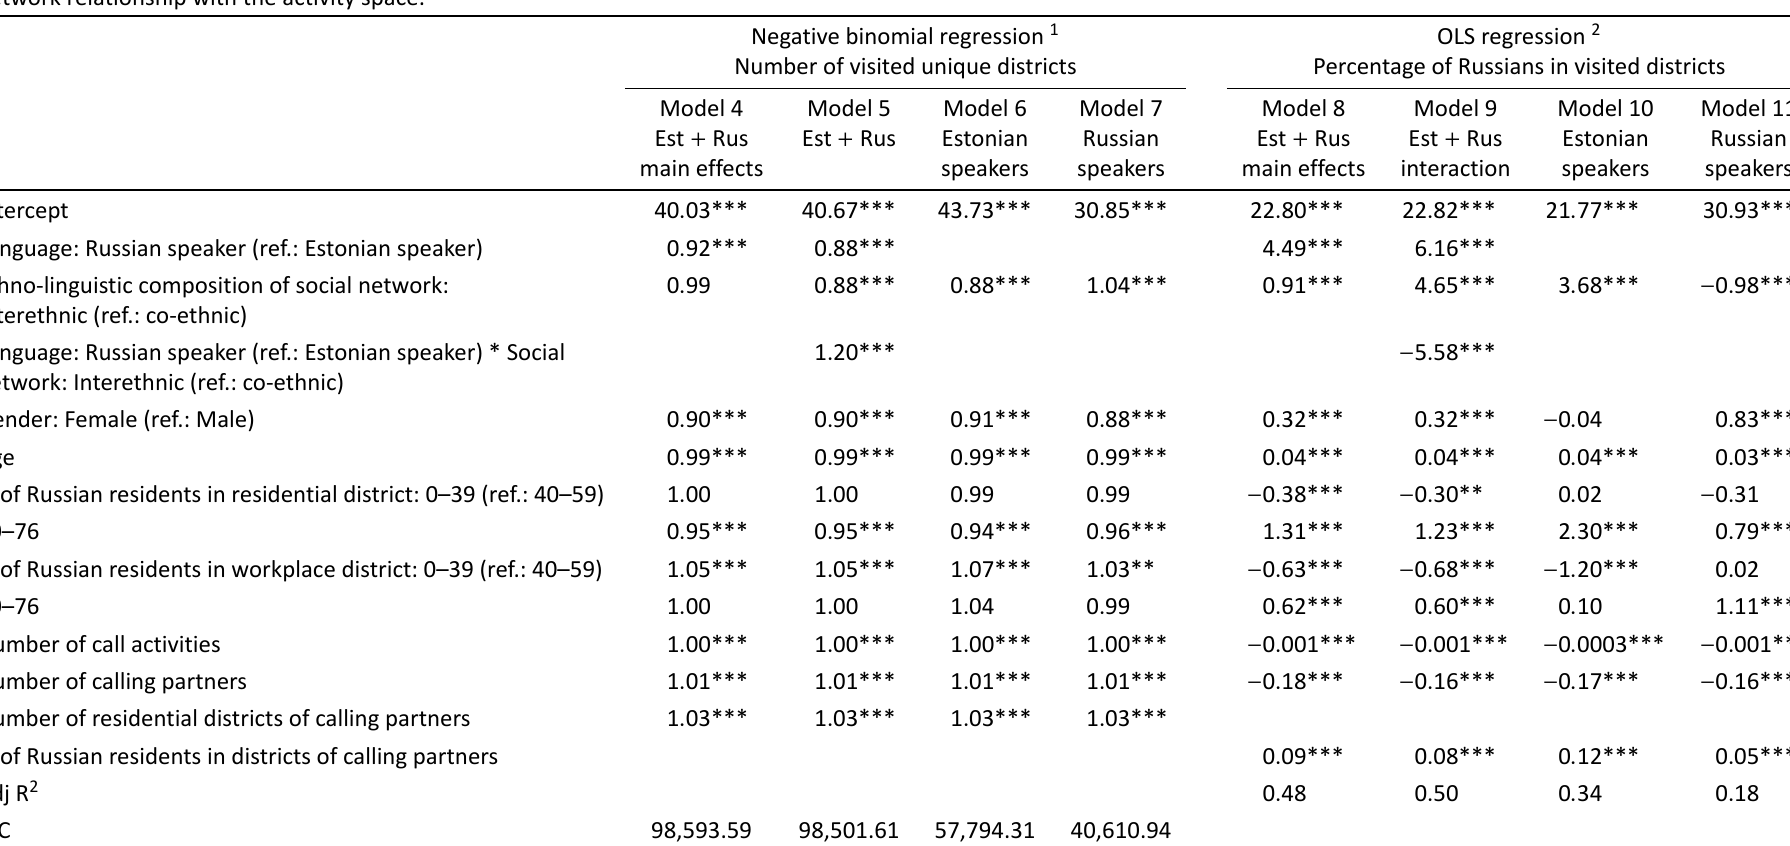
Table 3. The relationship between activity space and personal socio-demographic characteristics, the ethno-linguistic composition of place of residence and workplace, and social network relationship with the activity